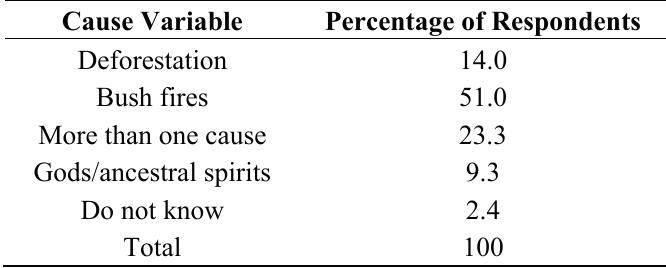
Ghana ( Number of respondents = 100).